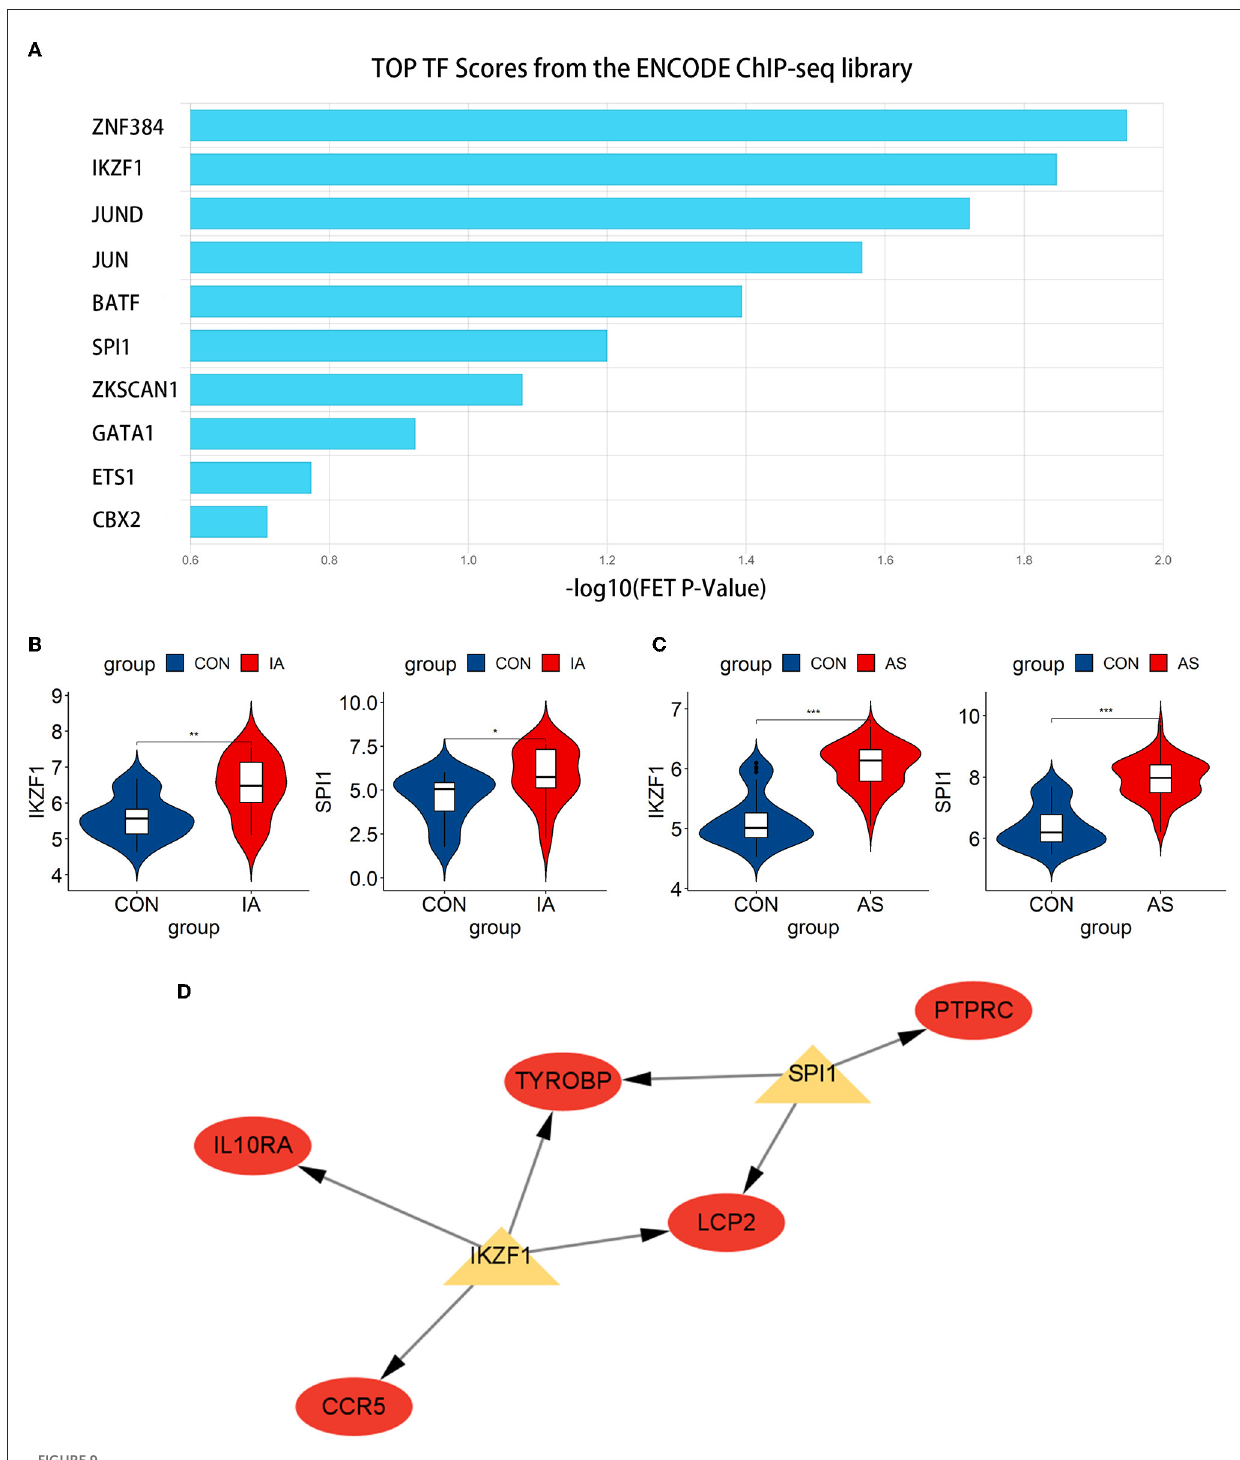
FIGURE9 Exploration and verification of TFs and their regulatory networks. (A) Top 10 related TFs predicted using the ChEA3 database. (B, C) TFs expression level in GSE75436 and GSE100927. The mean t -test is used for the comparison of the two datasets. Statistical significance was determined when the P -value < 0.05. IA, intracranial aneurysm wall tissue; AS, atherosclerotic samples; CON, control arteries. * p < 0.05; ** p < 0.01; *** p < 0.001. (D) The regulatory network of TFs. The hub genes were highlighted in red, whereas TFs were highlighted in yellow.